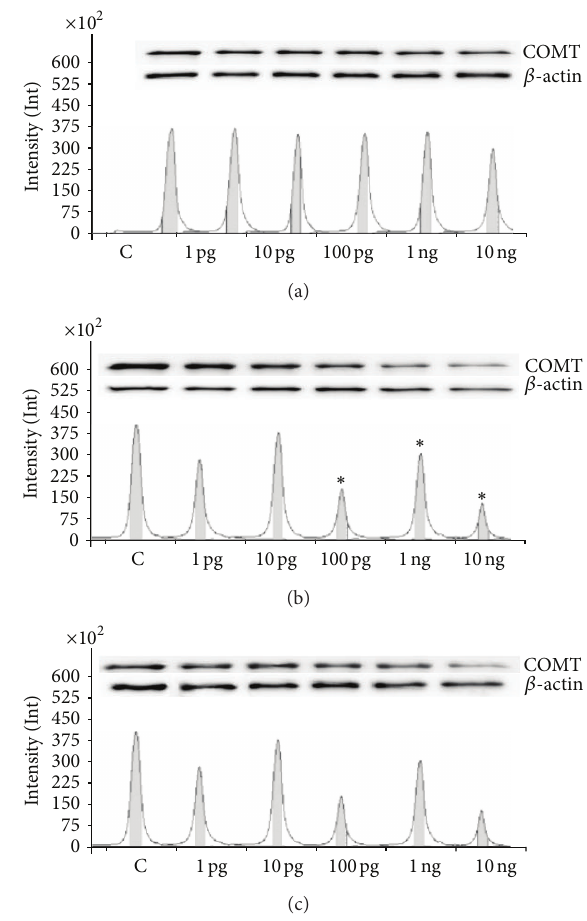
Figure 4: Protein expression (immunoblot) of COMT after 1 (a), 6 (b), and 48 (c) hours of incubation with Halowax 1051. The amount of protein in each sample was checked using an anti- 𝛽 - actin antibody. All means marked with ( ∗ 𝑃 < 0.05 ) are significantly different from the